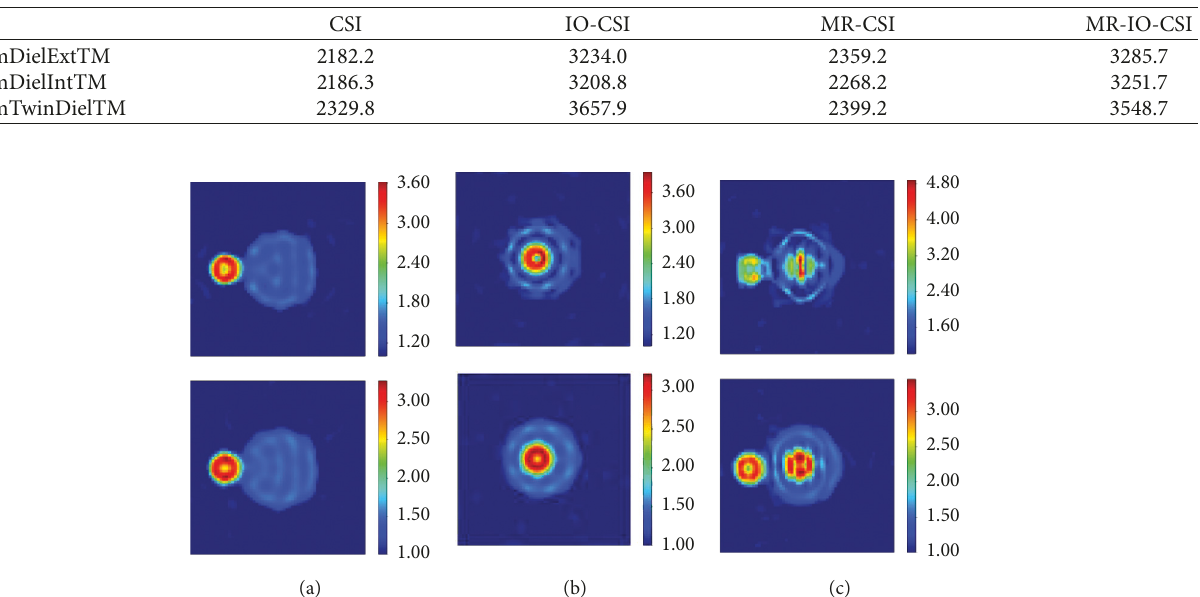
Table 2: The comparison of computation times